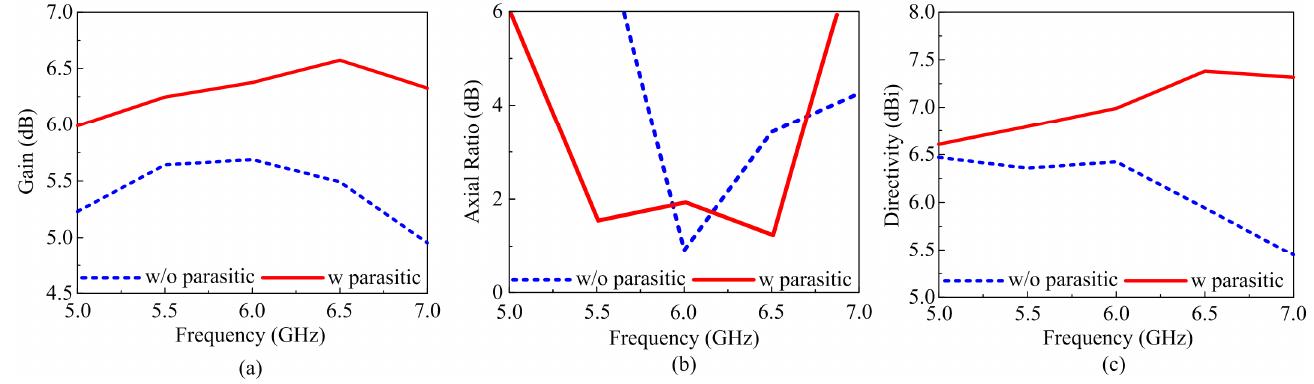
Figure 6. ( a ) Simulated gain of the antenna with and without parasitic. ( b ) Axial ratio of the antenna